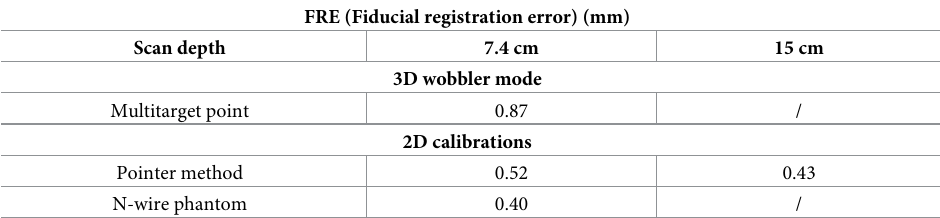
Table 1. Fiducial registration error for the 3D and 2D calibration